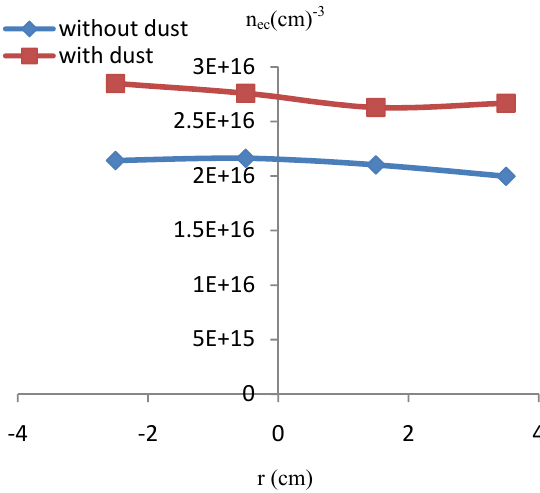
Fig. 12: Influence of Al dust on cold electron density.